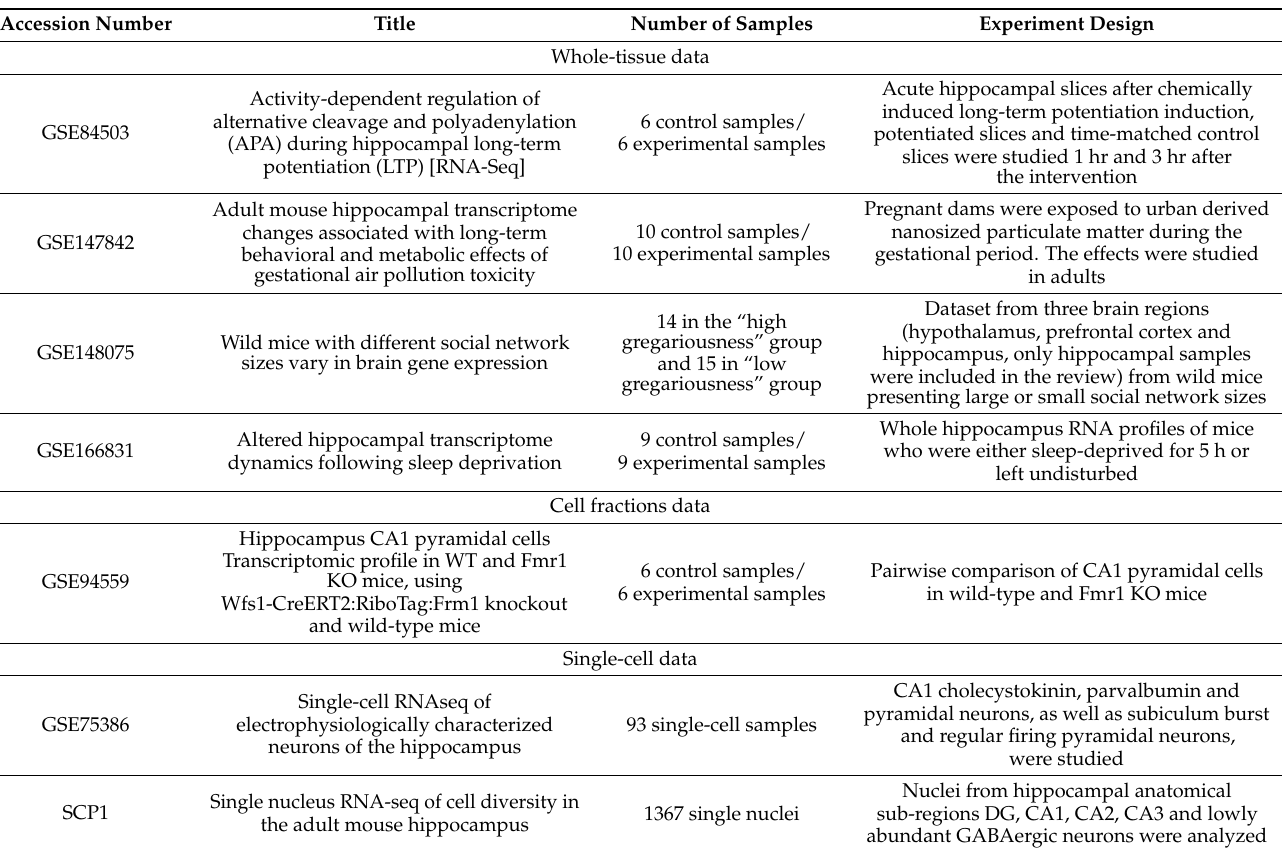
Table 1. RNAseq datasets included in the